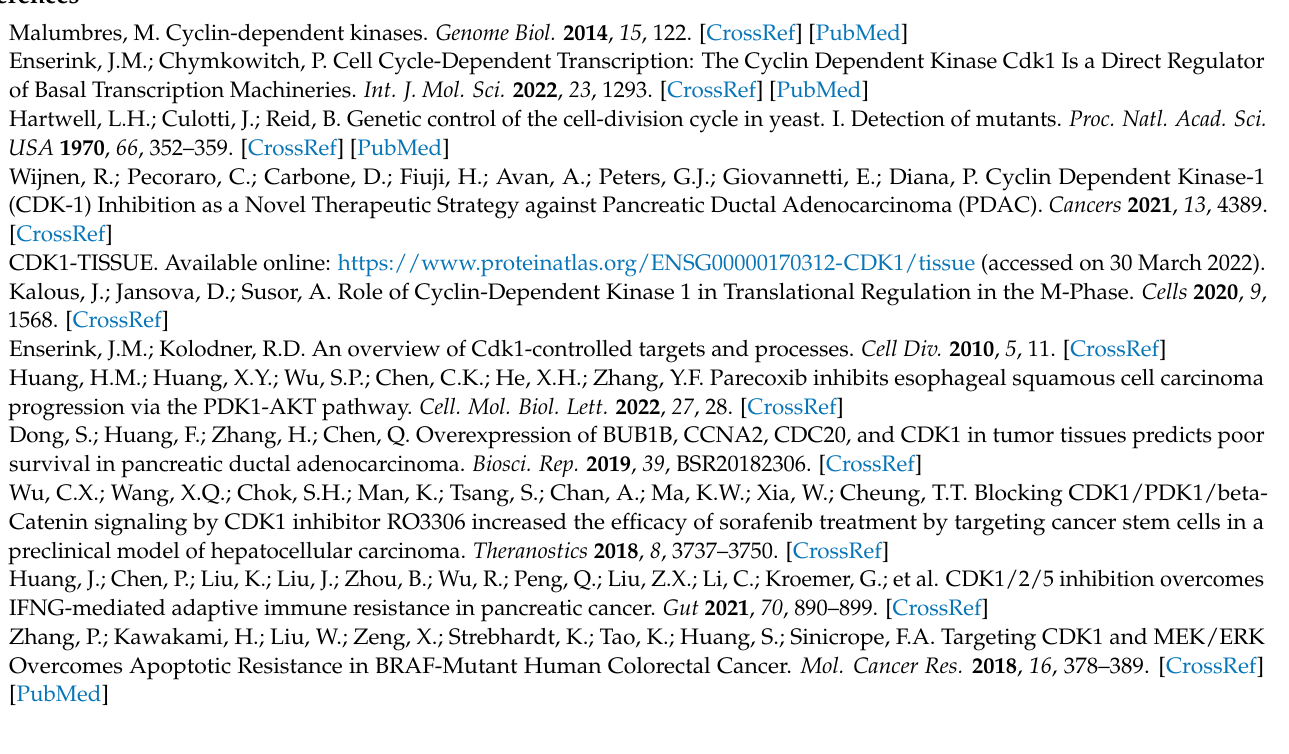
databases. Figure S3: The gene expression of CDK1 in different cancers based on the TCGA database. Figure S4: The correlation between CDK1 expression and various pathological stages of KIRC, BRCA, KIRP, LUAD ACC, and KICH based on the TCGA database. Figure S5: (A) The mRNA level of CDK1 was significantly decreased in LAML when compared to normal tissues. (B) C6 enrichment analysis showed that high expression of CDK1 was also associated with the genes that were upregulated with overexpression of oncogenes, such as E2F1 and KRAS in LAML of TCGA cohort. Figure S6: Kaplan– Meier curves of overall survival analysis in ACC for cancer patients with low CDK1 expression and high CDK1 expression. Table S1: Tumor abbreviations of TCGA database. Table S2: The interacted and correlated genes of CDK1 . Table S3: Raw data of correlation between CDK1 expression and ESTIMATEScore, ImmuneScore, and StromalScore in tumors of TCGA